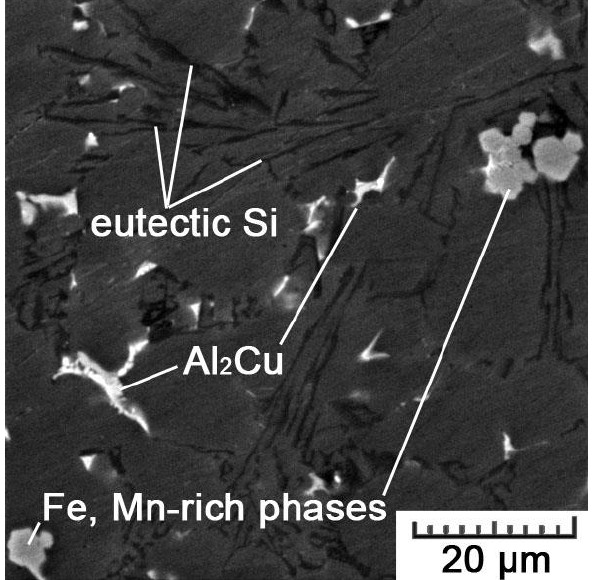
9 Cu 3 Fe alloy. Materials 2018 , 11 , x FOR PEER REVIEW